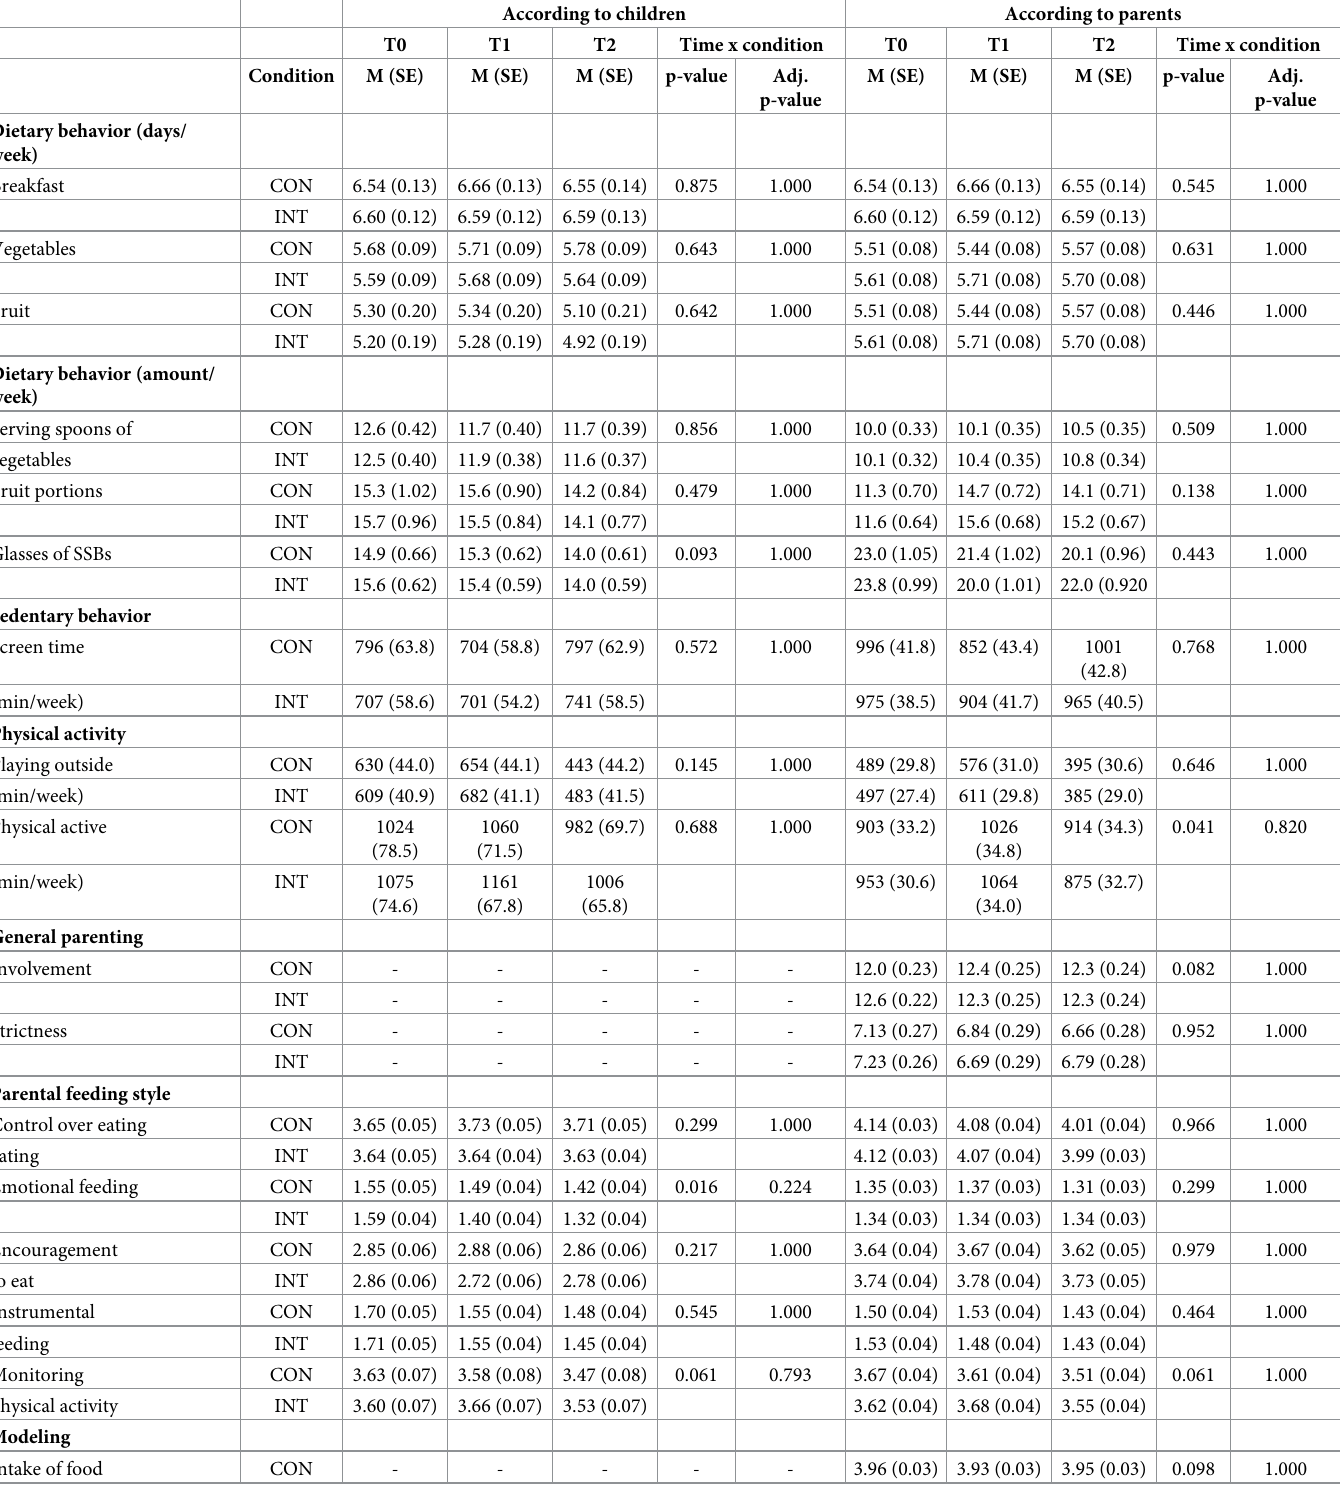
Table 3. Estimated marginal means per condition and measurement point and time by condition interactions for continuous outcomes (Intention-to-treat). According to children According to